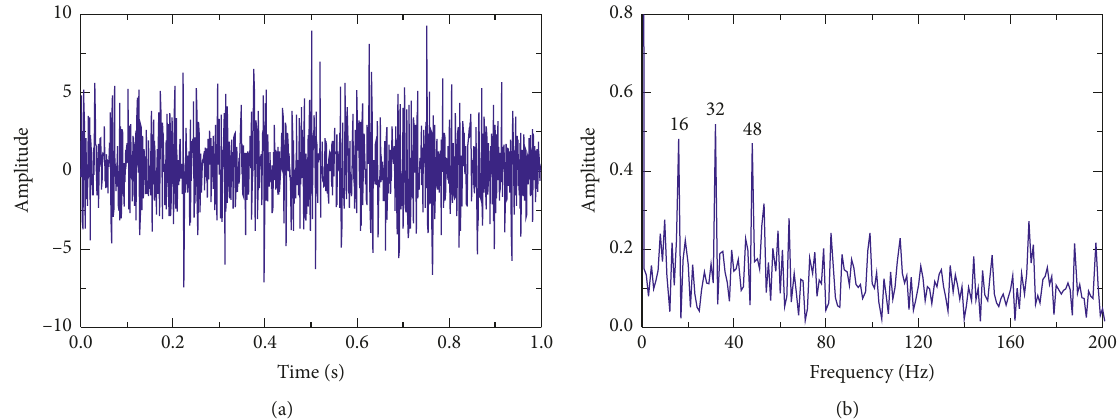
Figure 10: Impulsive extracting results of MCMFH: (a) waveform; (b) frequency spectrum.